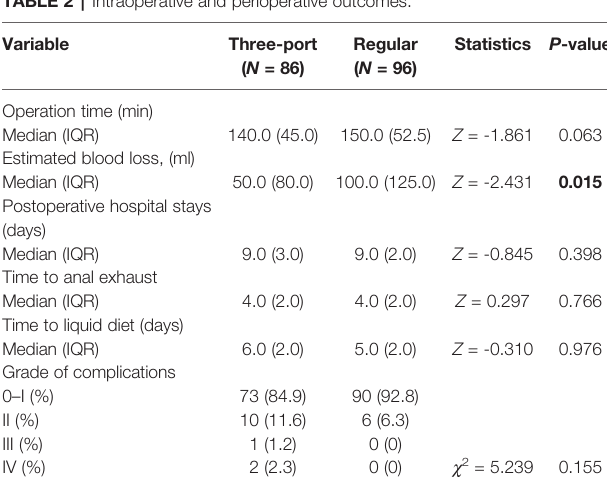
TABLE 2 | Intraoperative and perioperative